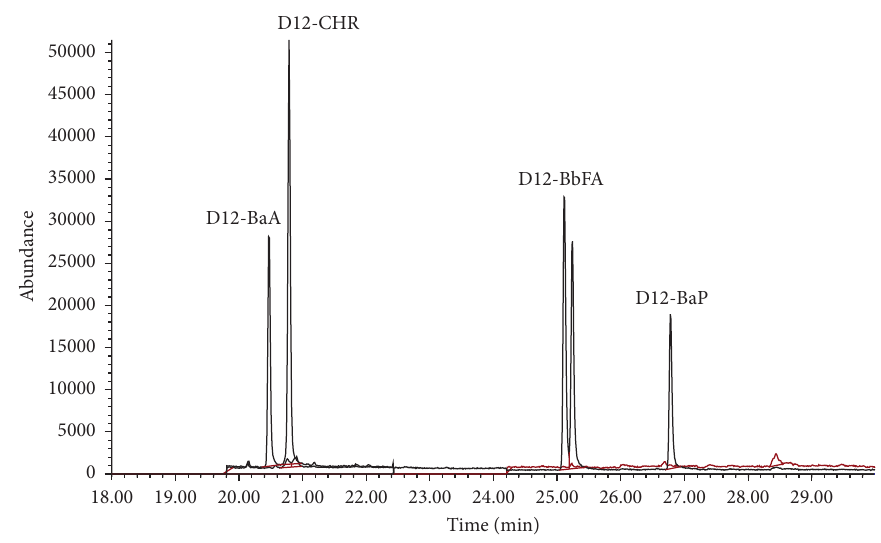
Figure 3: Total ion flow chromatogram of the blank